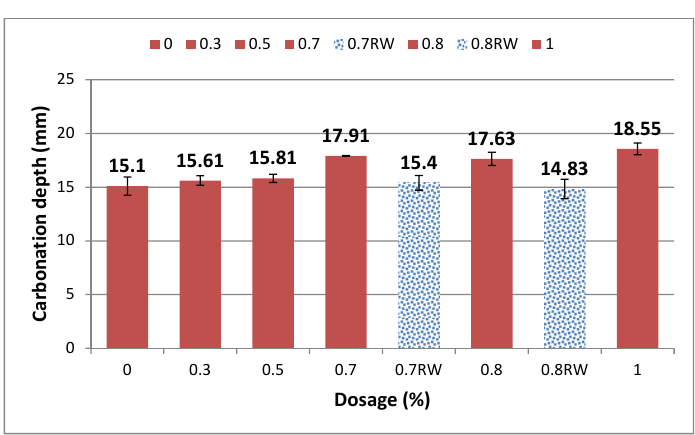
Figure 10. Carbonation of concrete